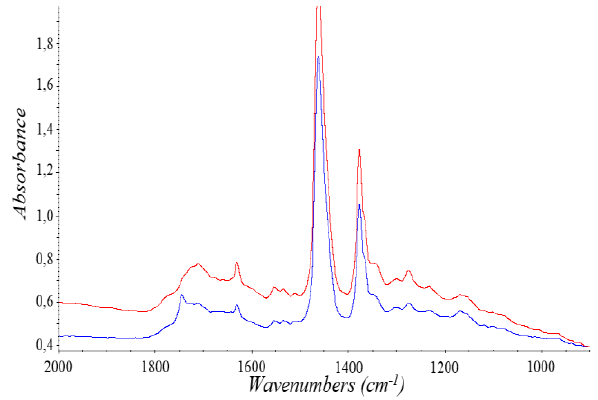
Fig. 6. Infrared spectrum (range 2000 cm –1 –900 cm –1 ) of a partial of soluble sediment taken from the flue gas duct (red) and the zone of the mushroom valve seat